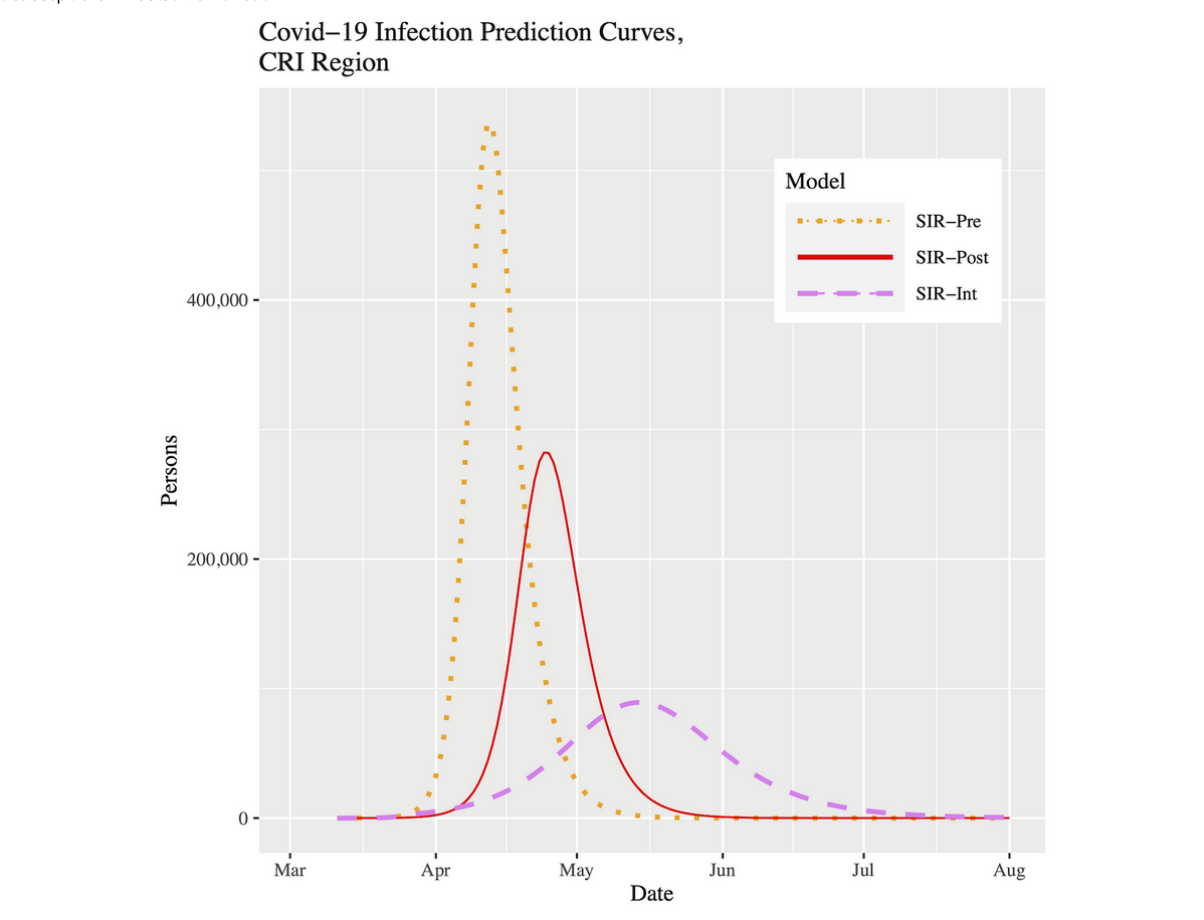
Figure 8. Infection prevalence prediction curves for the CRI up to August 1, 2020. COVID-19: coronavirus disease; CRI: Cities Readiness Initiative; SIR: susceptible-infected-removed.